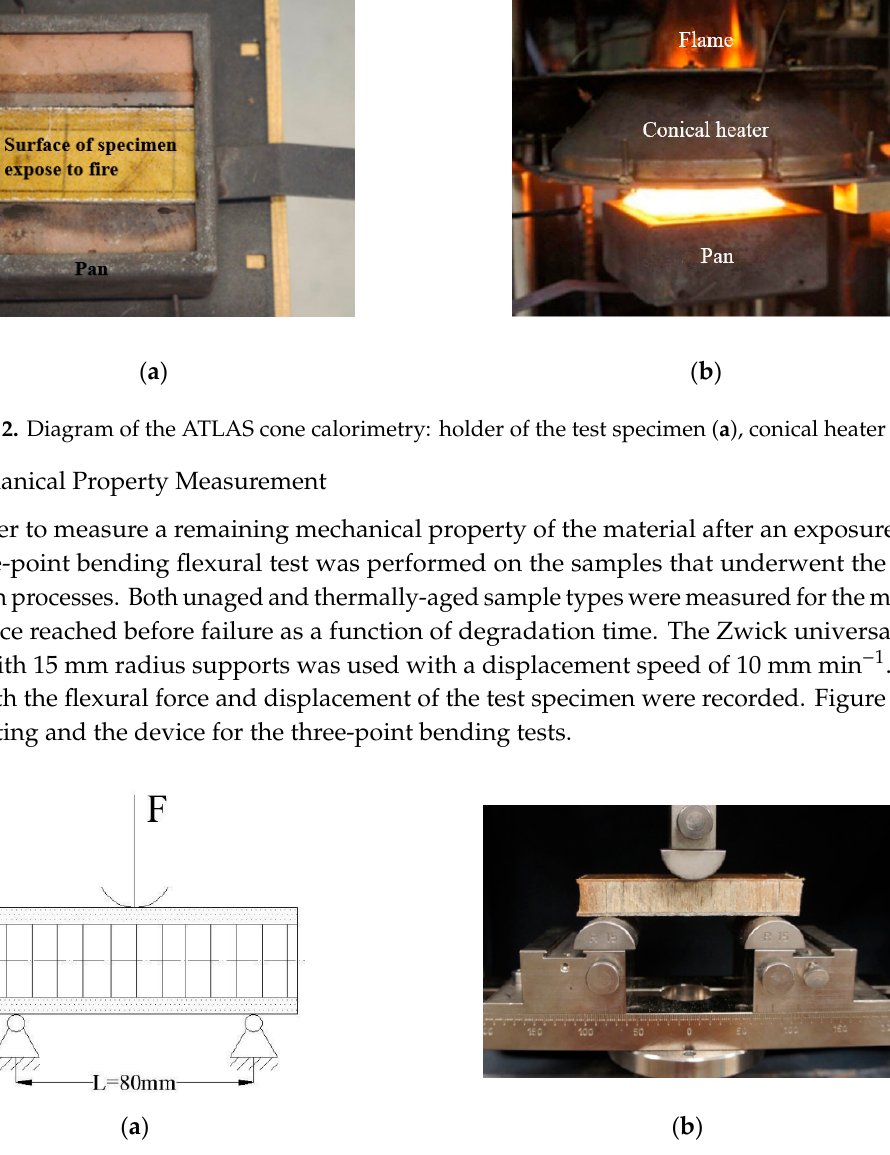
Figure 3. Sketch of the supporting ( a ) and the device ( b ) for the three-point bending tests of sandwich beams.